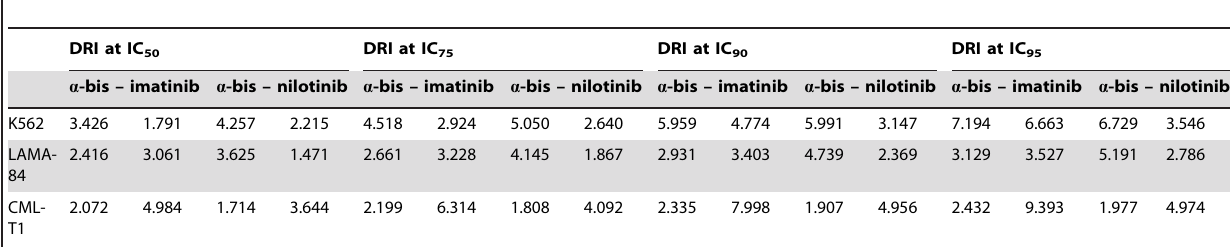
Table 2. Dose Reduction indices (DRI) in synergysm experiments using drugs in constant ratio.